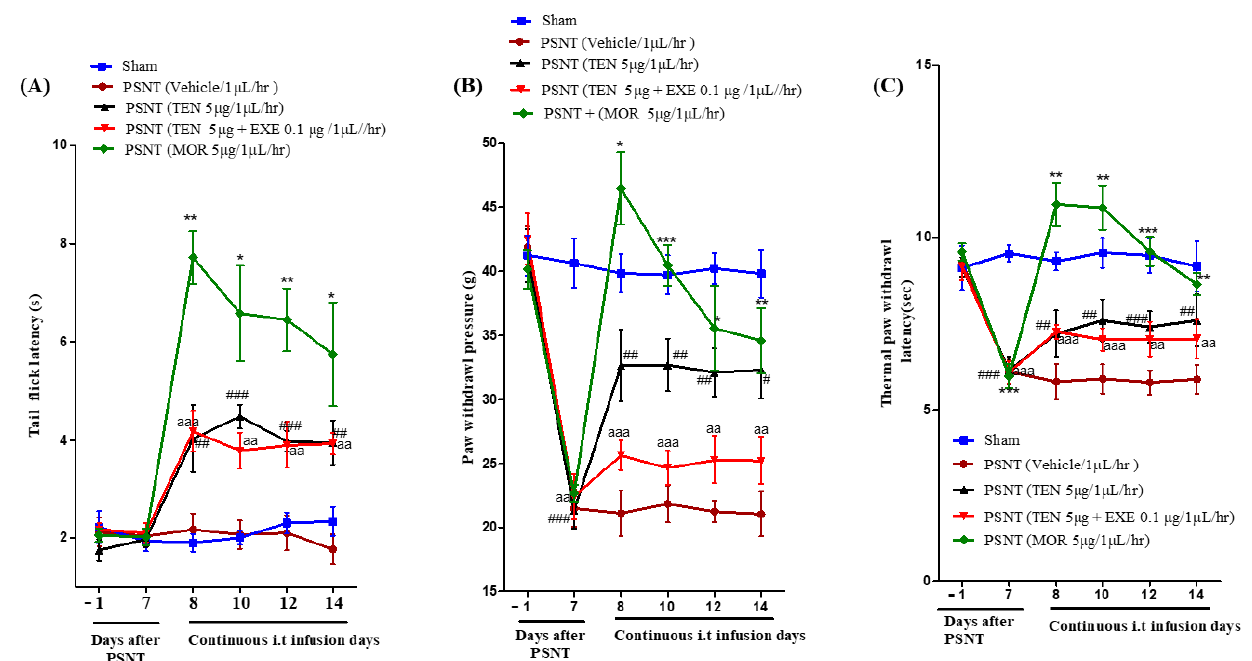
Figure 1. ( A ) Antinociceptive effects of TEN against acute pain. Tail−flick latencies were measured in sham rats and PSNT rats on days −1 (baseline before osmotic pump installation in PSNT rats) and day 7 after nerve transection. On day 7 osmotic pump is installed after baseline measurement and tail-flick latency was measure on days 8, 10, 12, and 14 by continuous i.t. infusion of vehicle (1 µL/h), TEN (5 μg/1 μL/h), TEN (5 μg) + EXE (0.1 μg)/1 μL/h, and MOR (5 μg/1 μL/h). ( B ) Effect of TEN continuous infusions on mechanical paw withdrawal pressure in PSNT rats. Paw withdrawal threshold against mechanical stimuli was measured in sham rats and PSNT rats on day −1 (Baseline before osmotic pump installation in PSNT rats), and on day 7 after nerve transection. On day 7 osmotic pump is installed after baseline measurement and paw withdrawal pressure was measured on days 8, 10, 12, and 14 by continuous i.t. infusion of vehicle (1 µL/h), TEN (5 μg/1 μL/h), TEN (5 μg) + EXE (0.1 μg)/1 μL/h, and MOR (5 μg/1 μL/h). ( C ) Effect of TEN continuous infusions on thermal paw withdrawal latency in PSNT rats. Paw withdrawal threshold against infra-red heat source is measured in sham rats and PSNT rats on days −1 (Baseline before osmotic pump installation in PSNT rats), and on day 7 after nerve transection. On day 7 osmotic pump is installed after baseline measurement and paw withdrawal latency was measured on days 8, 10, 12, and 14 by continuous i.t. infusion of vehicle (1 µL/h), TEN (5 μg/1 μL/h), TEN (5 μg) + EXE (0.1 μg)/1 μL/h and MOR (5 μg/1 μL/h). * Denotes statistical difference b/n sham group vs. PSNT (MOR), # denotes significant difference b/n PSNT (TEN) vs. PSNT (MOR), and “a” denotes significant difference b/n PSNT (TEN) vs. PSNT (MOR), */#/a > 0.05, **/##/aa > 0.01, and ***/###/aaa > 0.001, ( n = 6 animals per group).